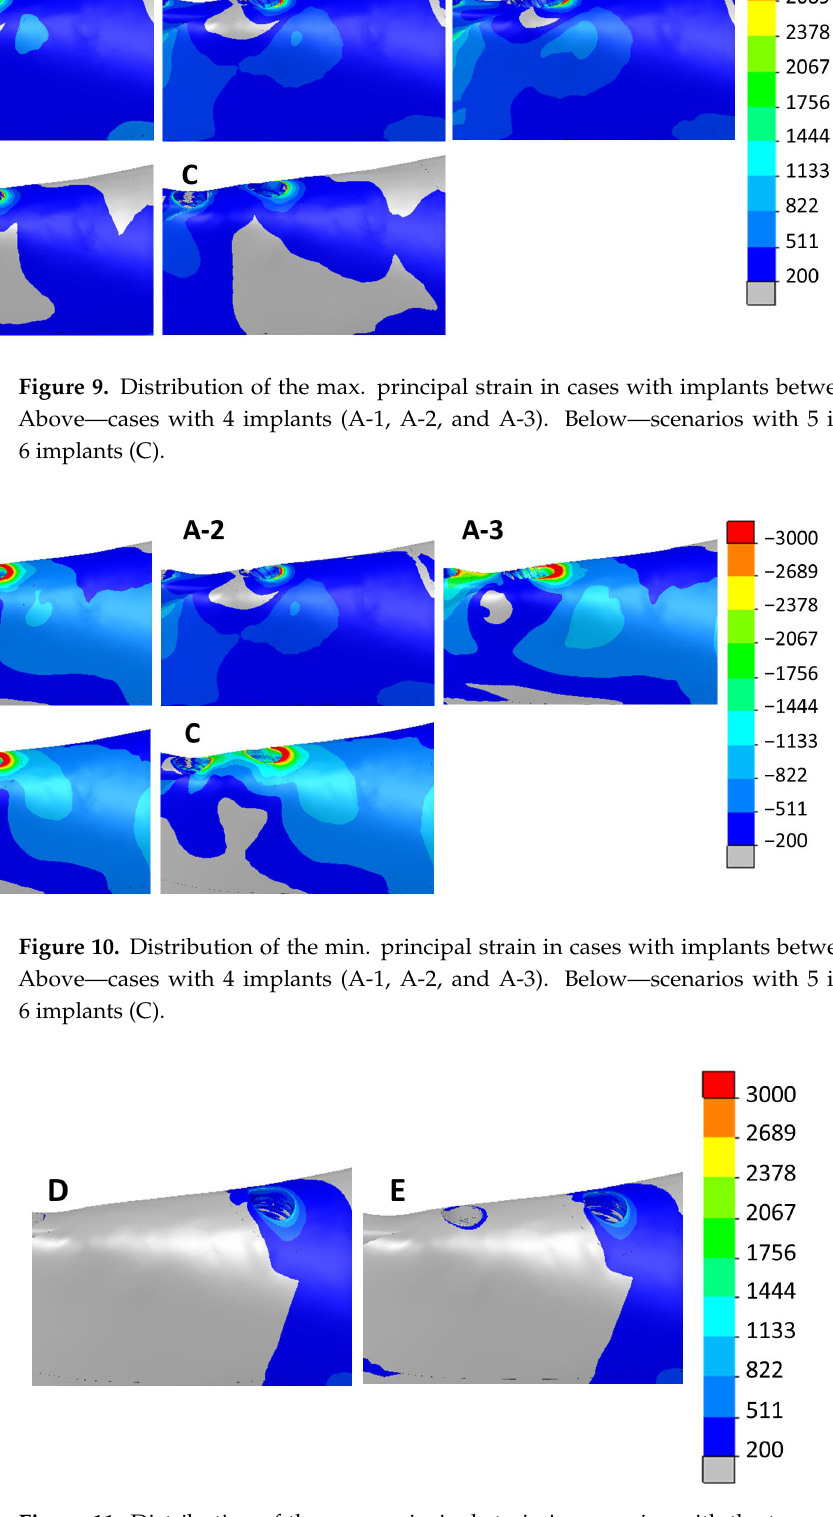
Figure 12. Distribution of the min. principal strain in scenarios with the two posterior implants moved distally to the foramina. Left—4 implants (D). Right—6 implants (E). Figure 13 shows the equivalent von Mises stress distributions in the ROIs for sce- narios with implants located between the foramina. Figure 14 shows the von Mises